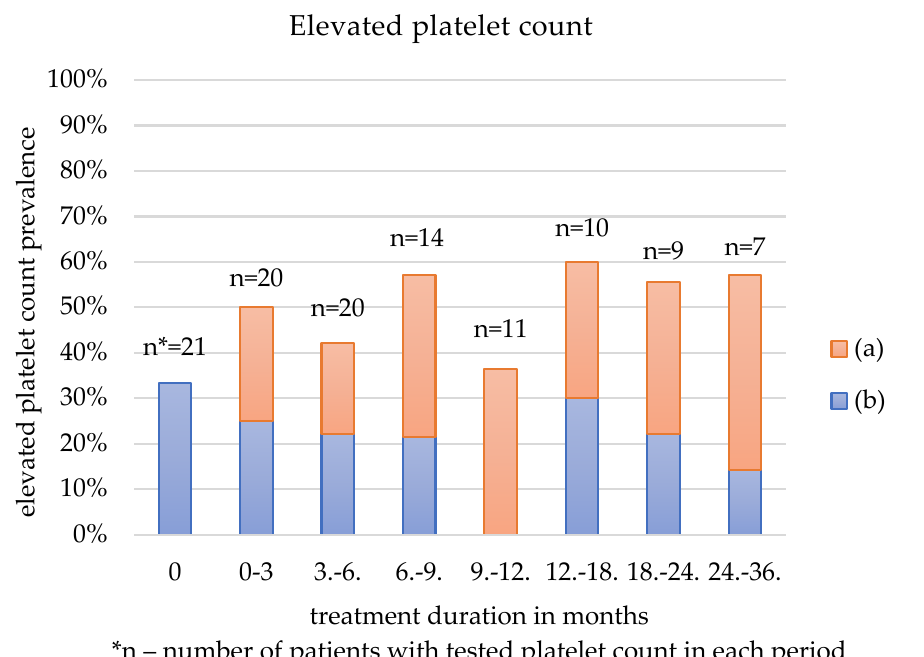
Figure 2. Elevated platelet count depending on the treatment duration in patients with: (a) platelet count within normal ranges prior to sirolimus treatment, (b) thrombocytosis prior to sirolimus treatment.